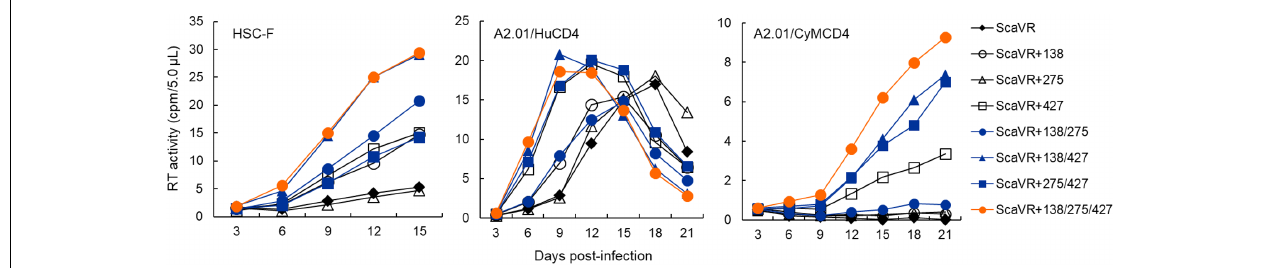
FIGURE 2 | Growth kinetics of ScaVR and its Env-gp120 mutants. Viruses were prepared from 293T cells transfected with proviral clones indicated and inoculated into HSC-F, A2.01/HuCD4, and A2.01/CyMCD4 cells as described in Section “Materials and Methods.” Virus replication was monitored by RT activity released into culture supernatants. Representative data from at least two independent experiments are